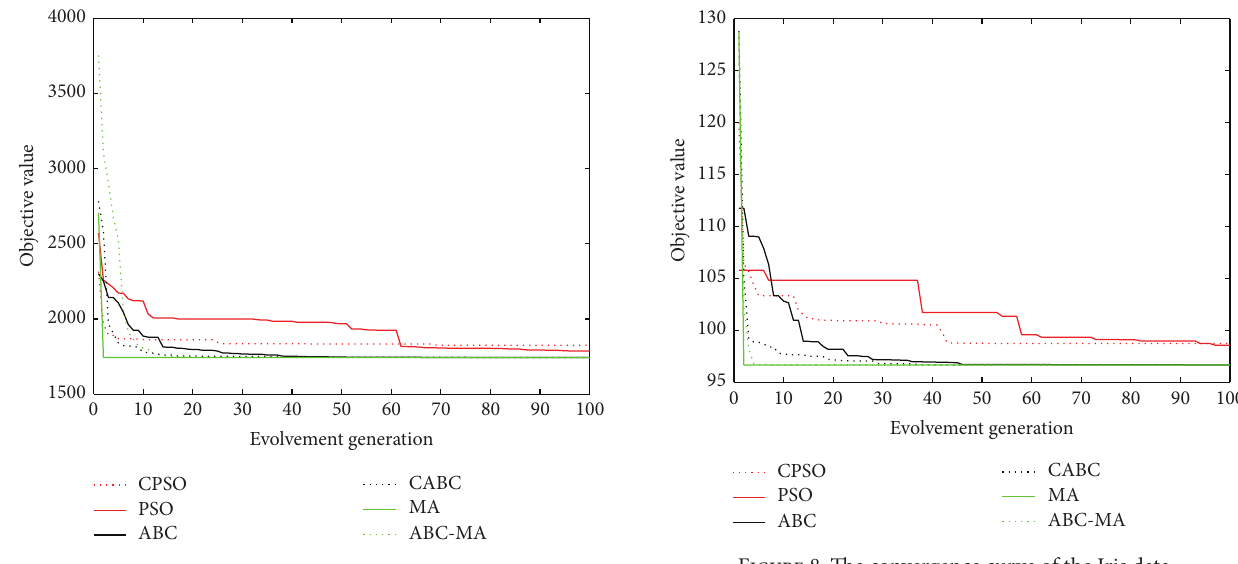
Figure 6: The convergence curve of the Art1 data.